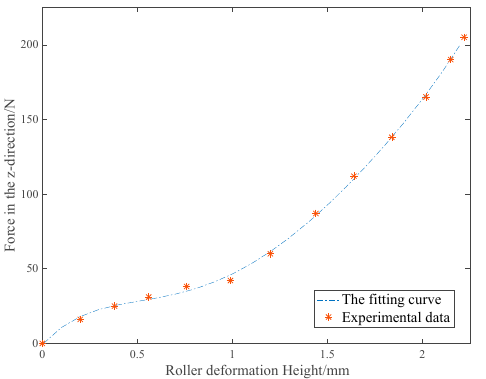
Figure 3. Relationship between vertical deformation height and compaction force.